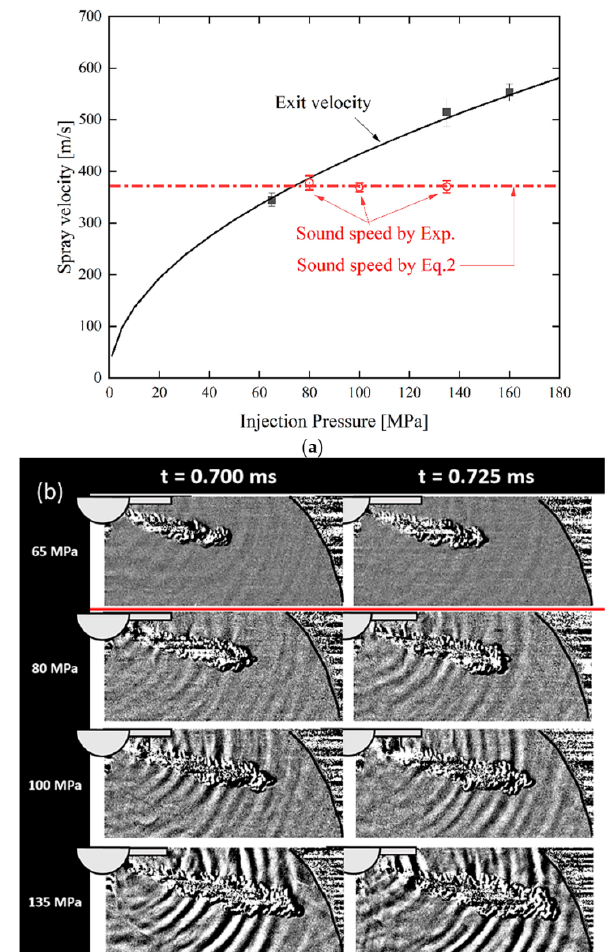
Figure 13. Shockwave generation in the high ambient temperature condition ( a ); ambient gas condition: mixture (12% H 2 O; 18% O 2 ; 70% CO 2 ), 500 K and 6.3 kg / m 3 ( b